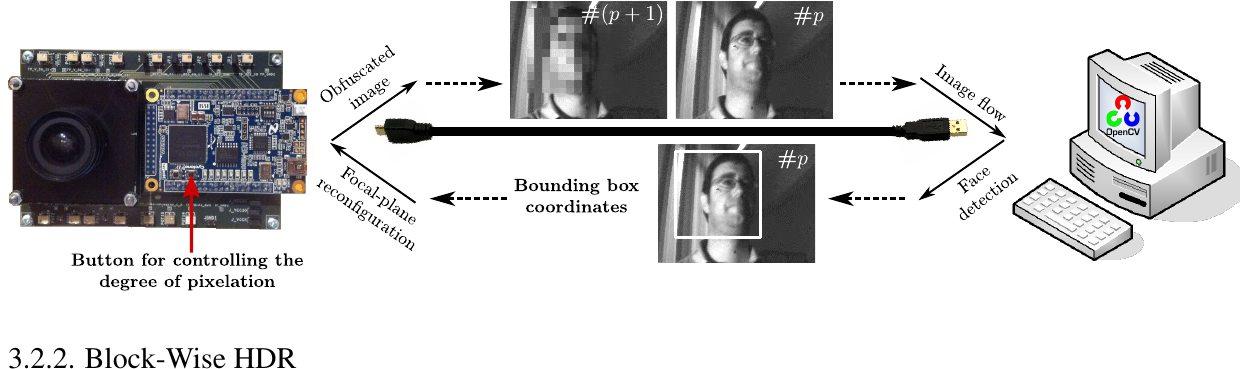
Figure 8. Real-time focal-plane reconfiguration conducted by the Viola–Jones frontal face detector. If faces are detected, the coordinates of the corresponding bounding rectangles are sent back to the test board for the vision sensor to reconfigure the image capture